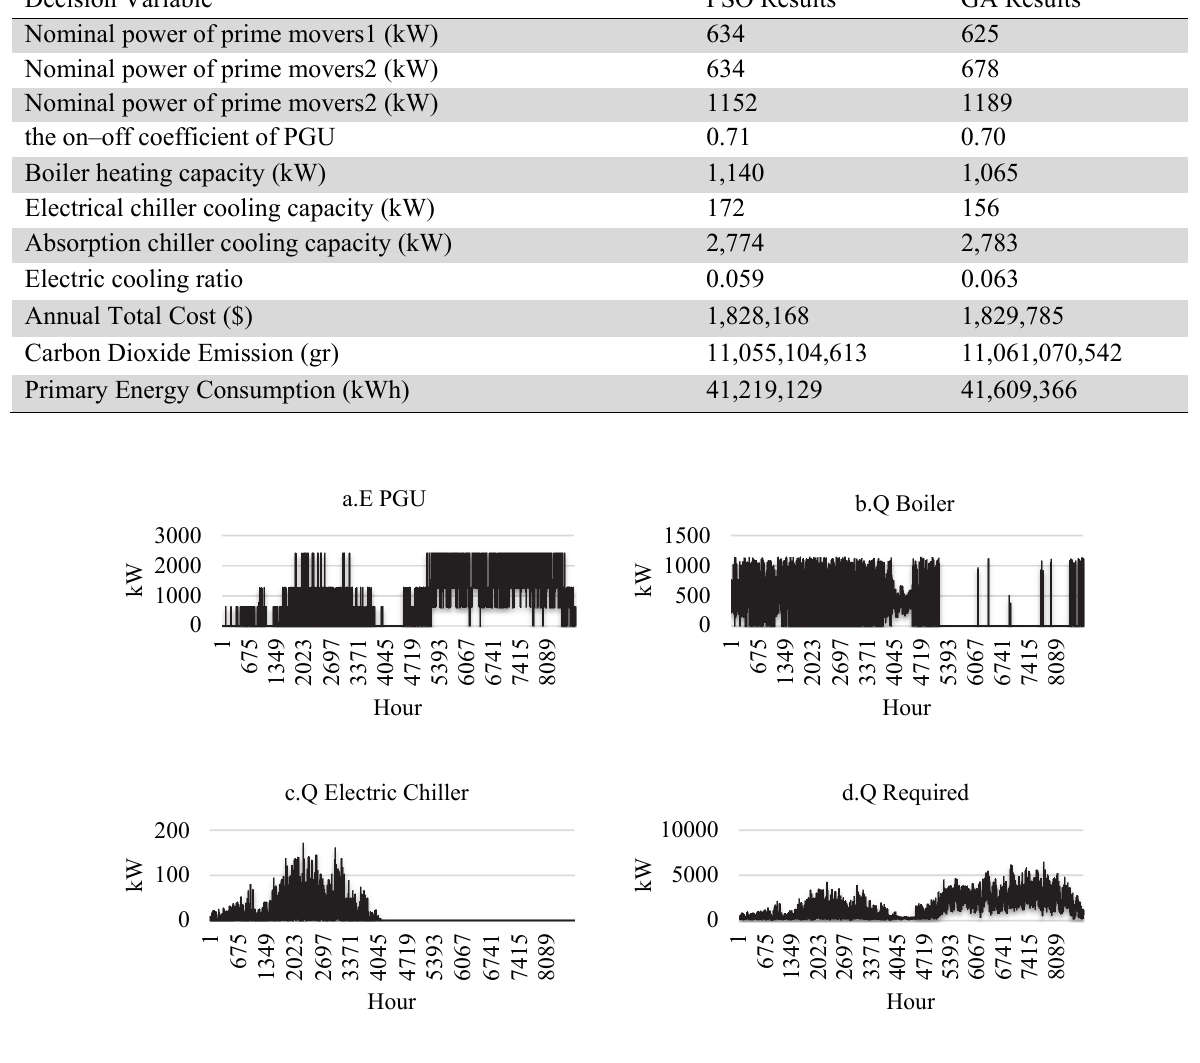
Fig. 10. Performance of system all year long (FTL, Multi